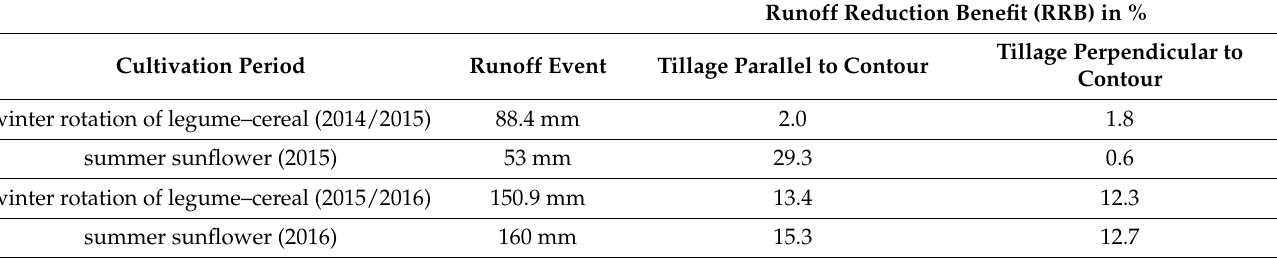
Table 3. Runoff reduction benefit (RRB) over the four cultivation periods.